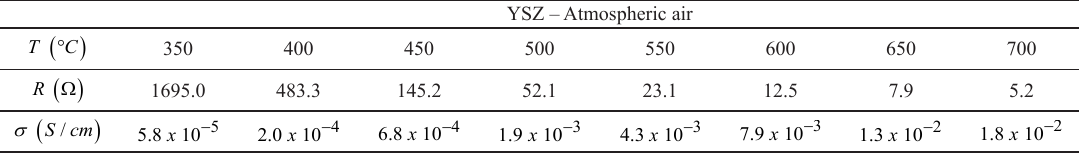
Table 5. Resistance and conductivity obtained by